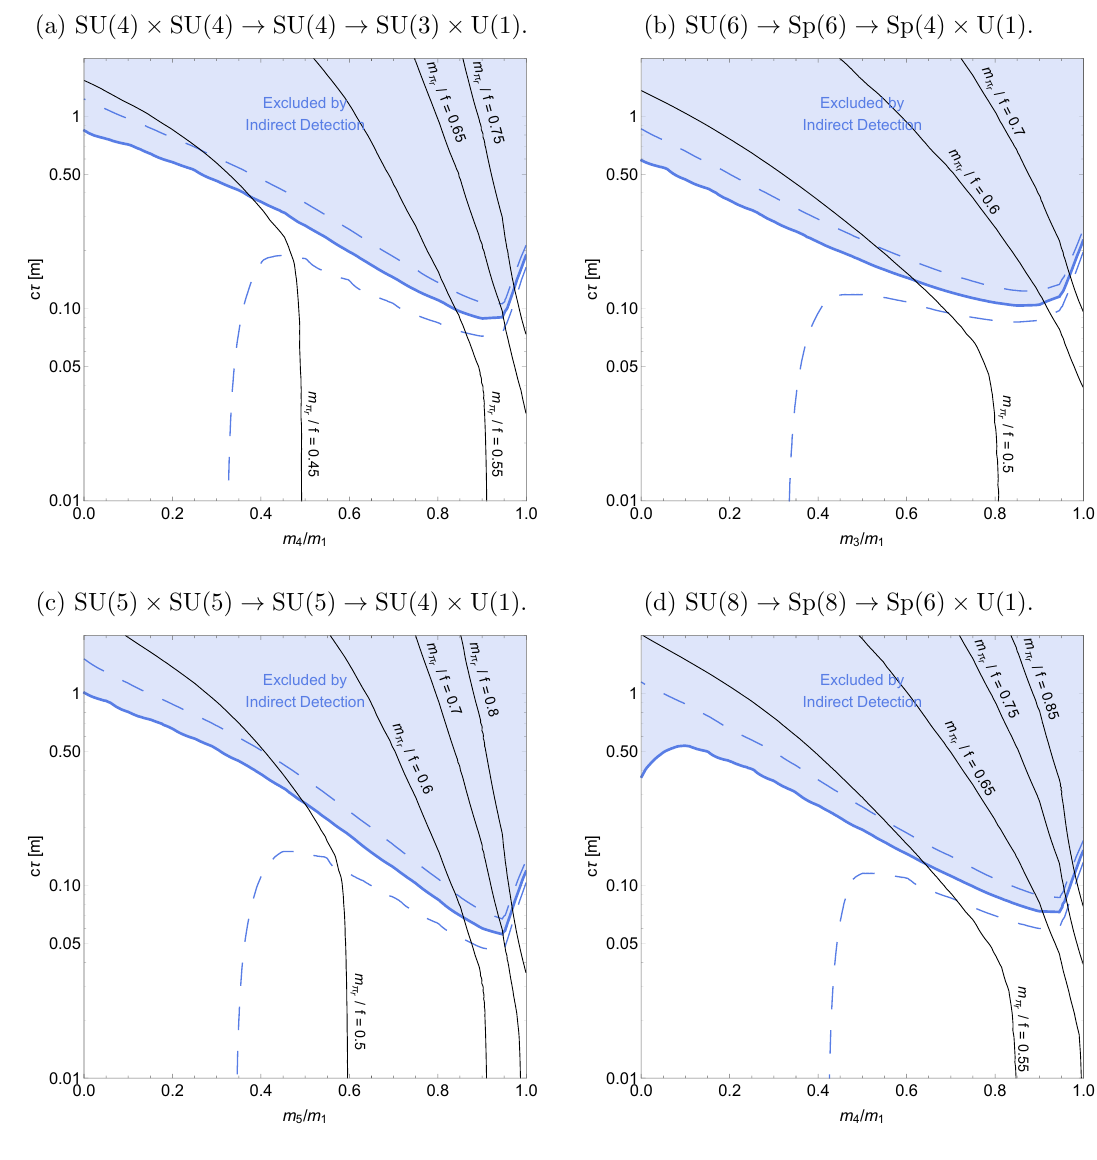
Figure 4. Allowed region of parameter space for di(cid:11)erent benchmarks of category I. For (a), (b), (c) and (d), the masses of the ( 8 ; 0) of SU(3) (cid:2) U(1), the ( 5 ; 0) of Sp(4) (cid:2) U(1), the ( 15 ; 0) of SU(4) (cid:2) U(1) and the ( 14 ; 0) of Sp(6) (cid:2) U(1) are respectively set to 75 GeV. The black contour lines represent constant values of m (cid:25) =f , where m (cid:25) is simply the representation mass kept constant, i.e. r r 75 GeV. The blue region is excluded by indirect detection dark matter searches. The dashed blue lines correspond to what the exclusion limit would be if the limit on the indirect detection e(cid:11)ective cross section were to vary by (cid:6) 10%.